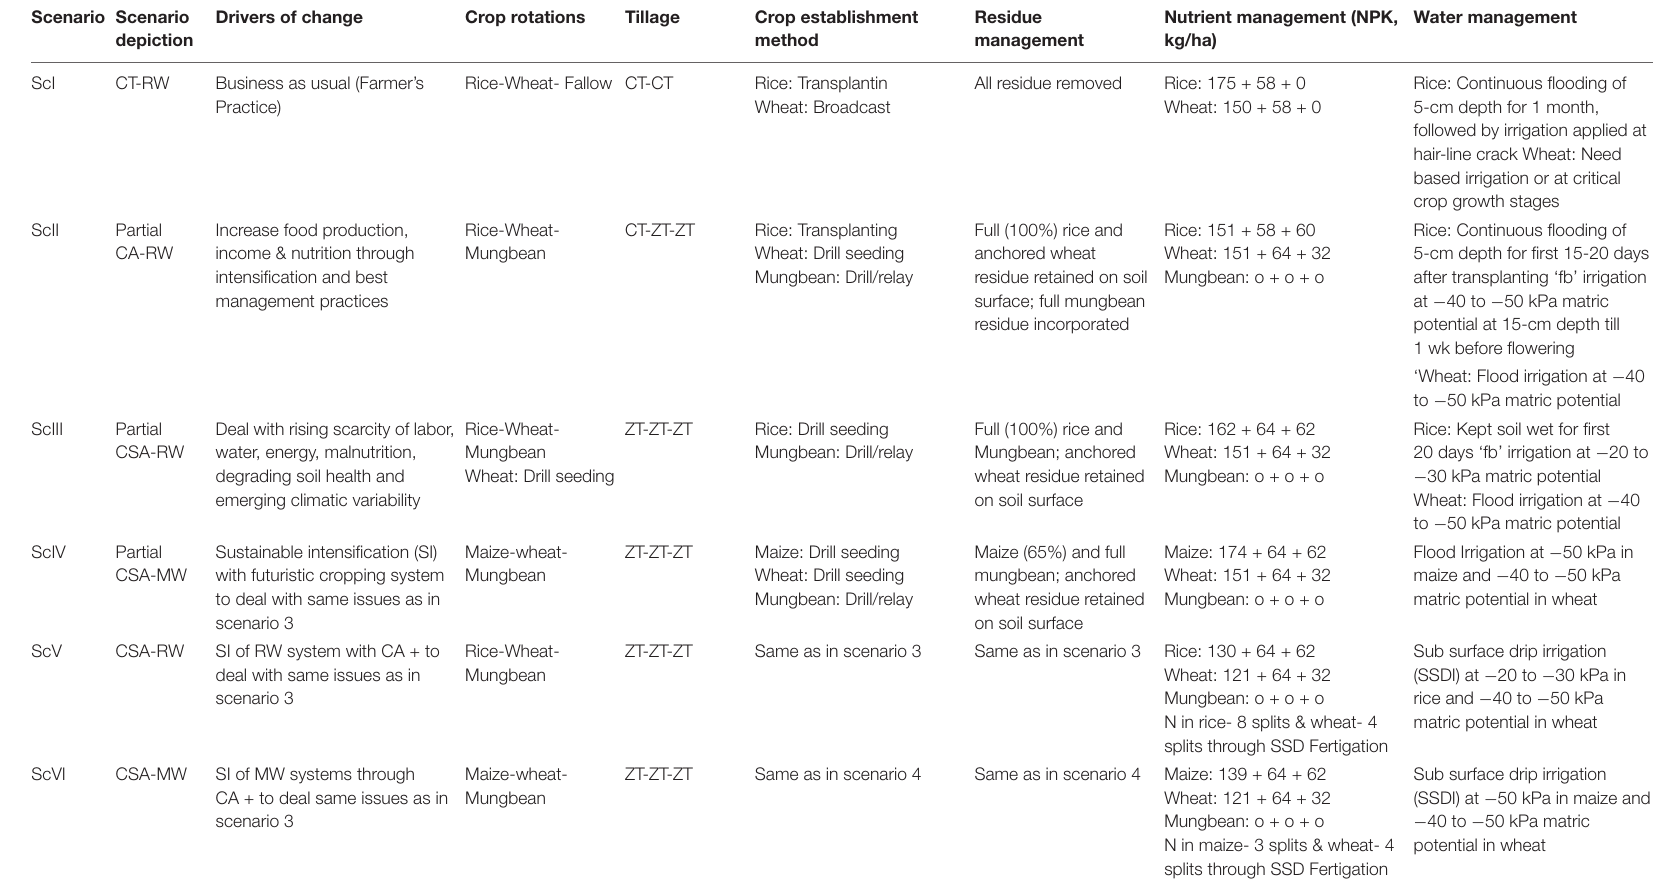
TABLE 1 | Drivers of agricultural change, crop rotation, tillage, crop establishment method, and residue management of different scenarios. Scenario Scenario Drivers of depiction